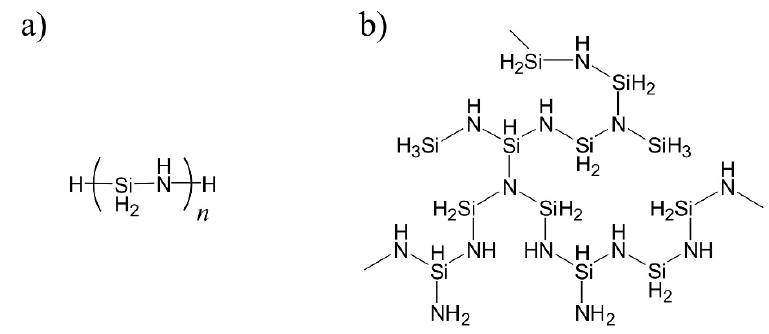
Figure 1. Composition formula ( a ) and structural formula ( b ) of perhydropolysilazane (PHPS).